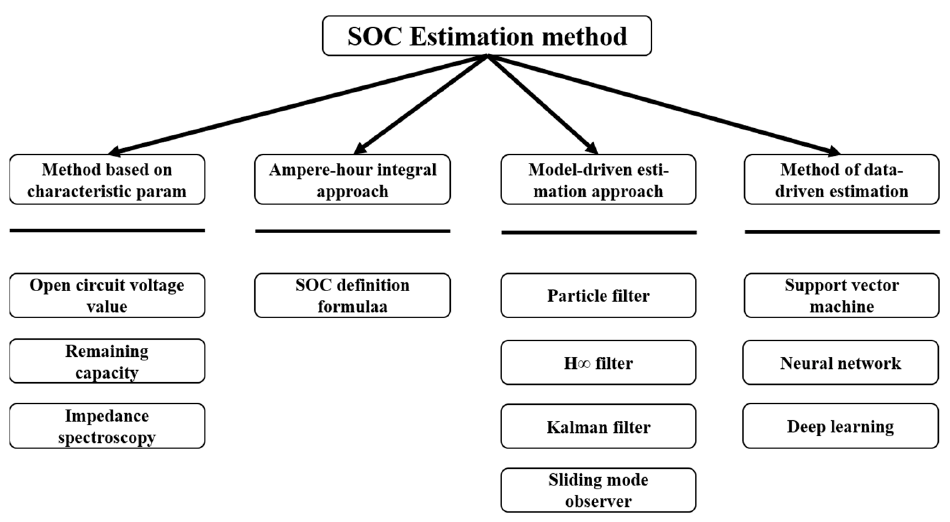
Figure 1. Classification of SOC estimation methods [26].